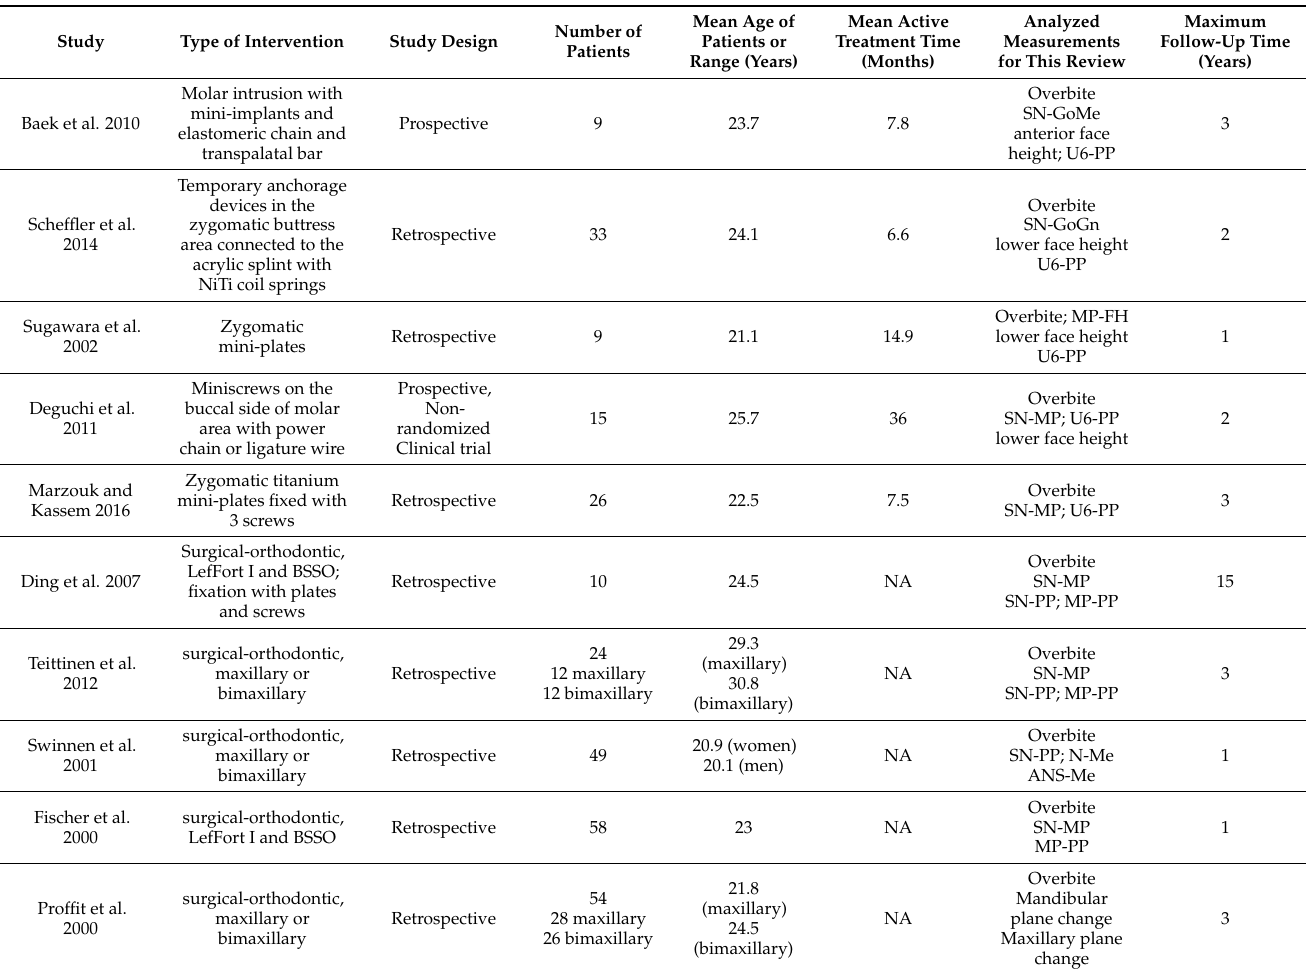
Table 6. Characteristics of studies included in the